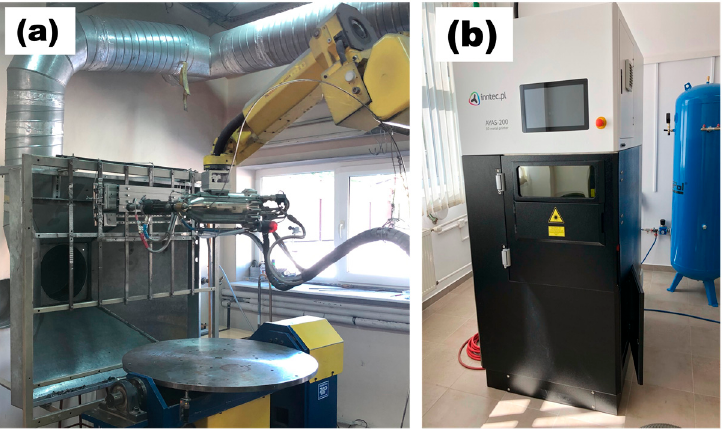
Table 1. Parameters of the cold-spray processes.